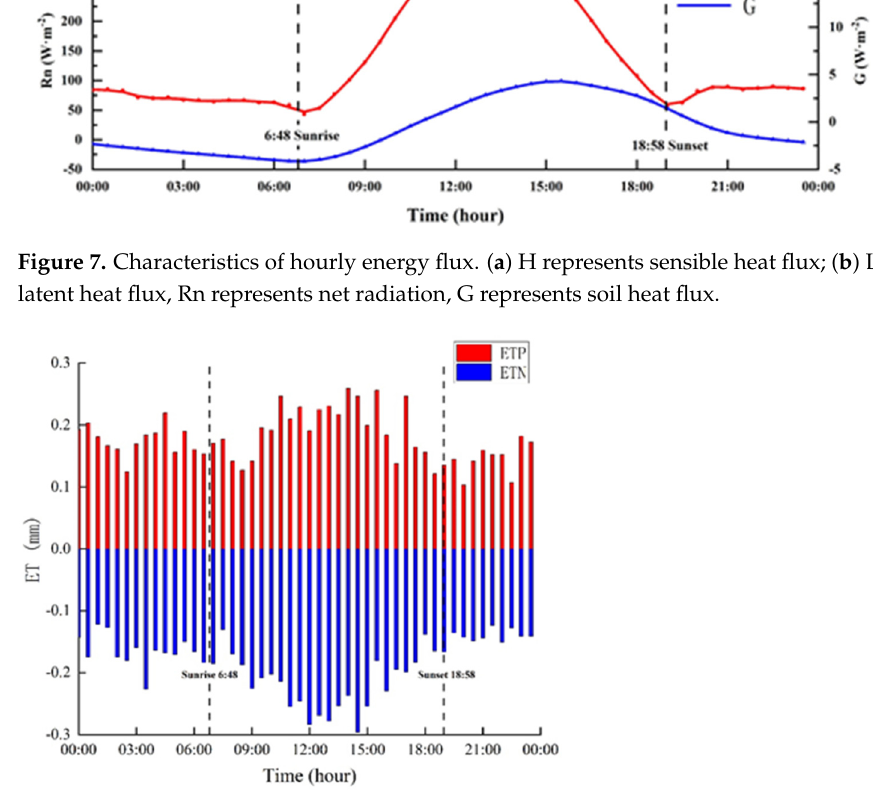
Figure 8. Characteristics of hourly evapotranspiration. ETP represents evapotranspiration positive value, ETN represents evapotranspiration negative value.